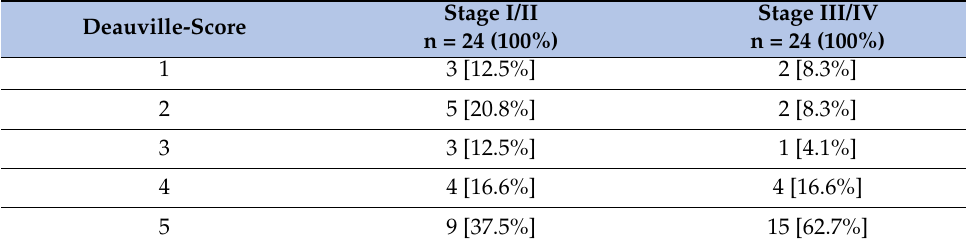
Table 3. Visual/manual Deauville Scoring before